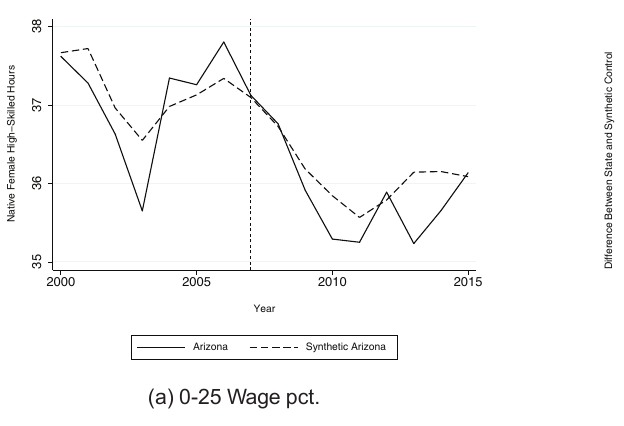
Figure A13 Native female weekly hours (0-25 wage pct. | hours >0)